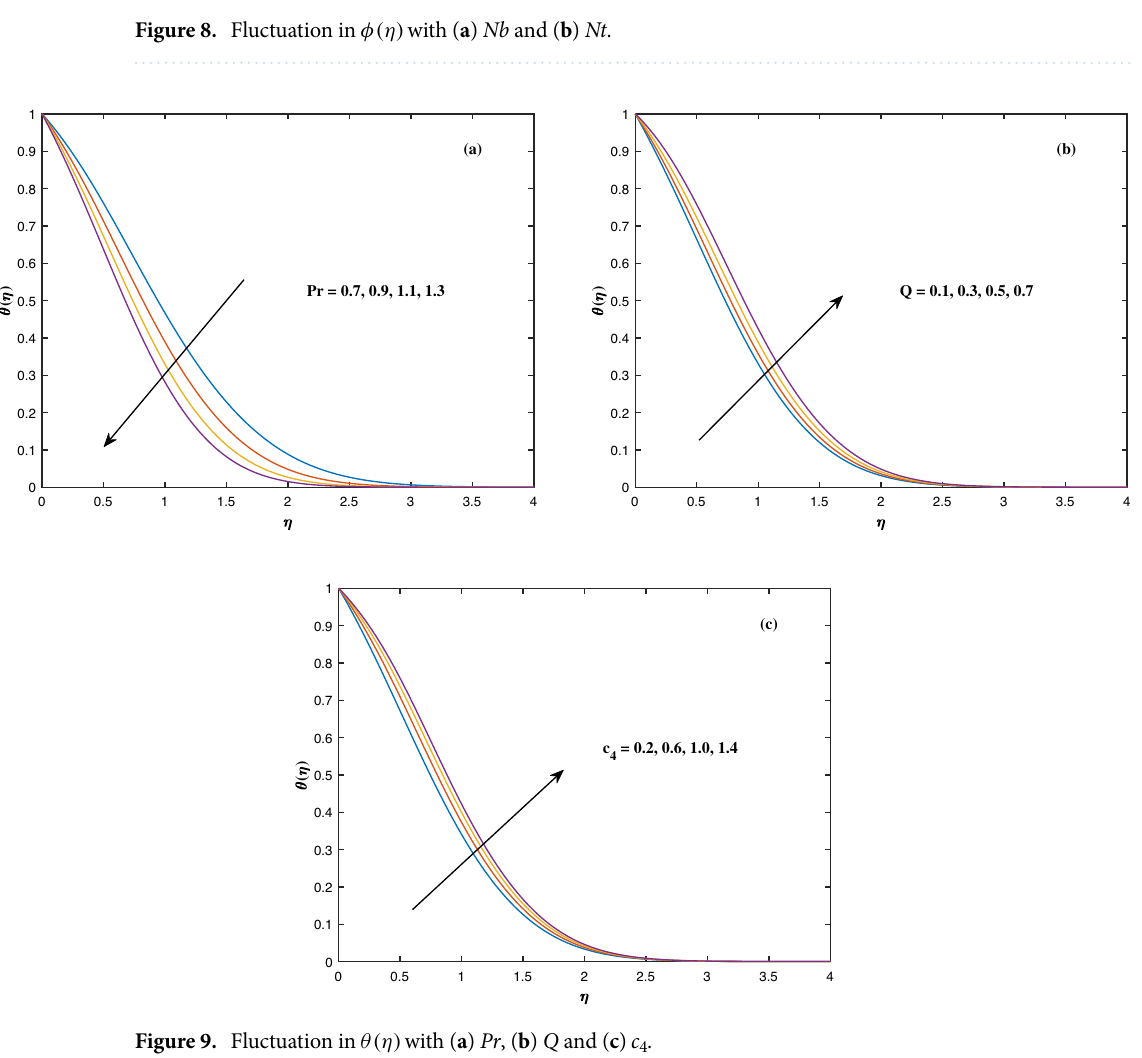
Figure 9. Fluctuation in θ(η) with ( a ) Pr , ( b ) Q and ( c ) c 4